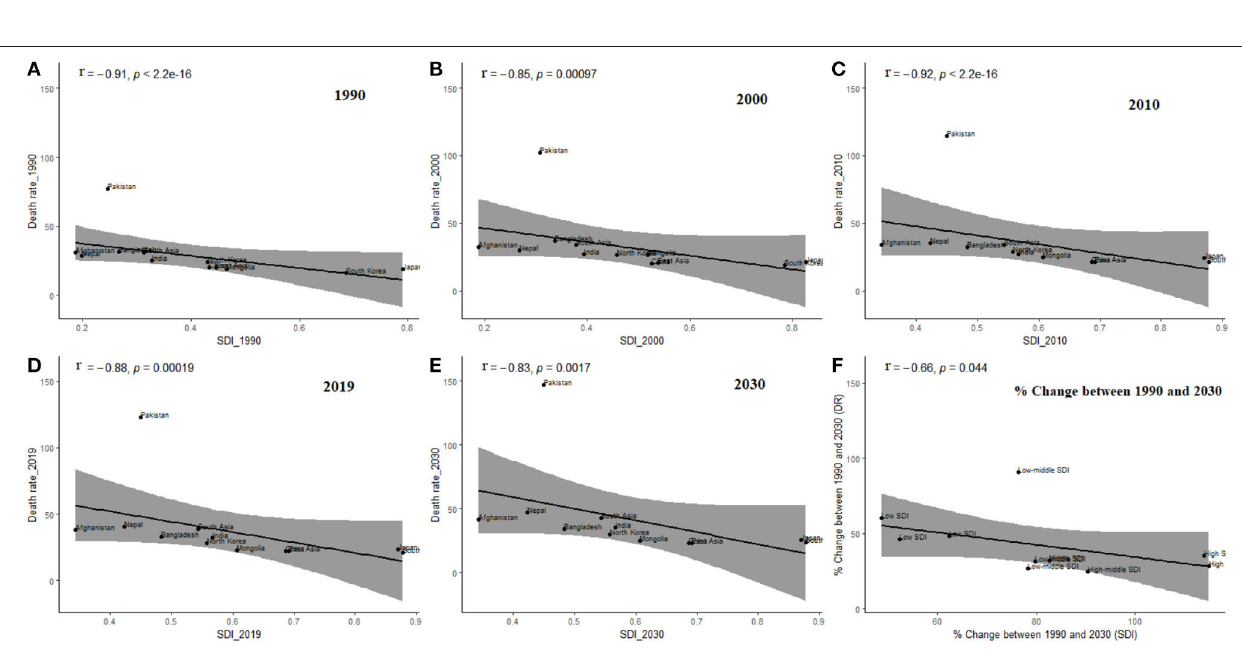
high-temperature cooking of red meat (60). The consumption of red meat has increased tremendously in the East Asian countries in the last few decades and is expected to be the region with one of the highest red meat consumption by 2030